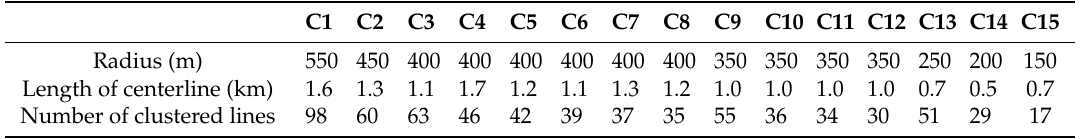
Table 3. Features of the centerline with flexible radius.